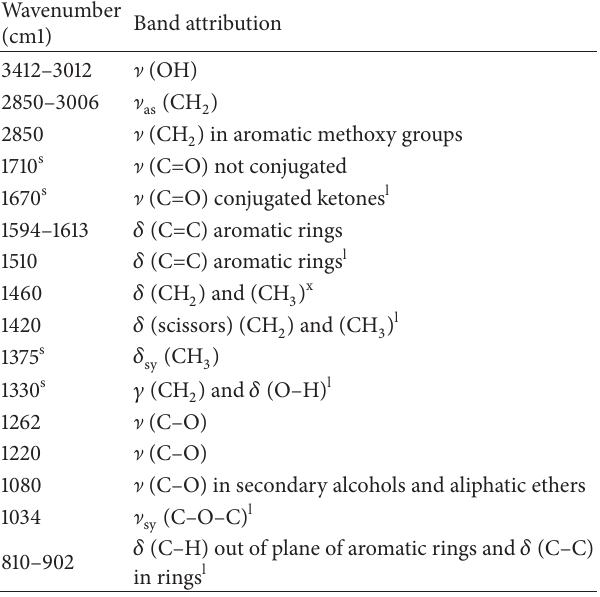
Table 7: Position and attribution of the IR absorption bands for lignin and